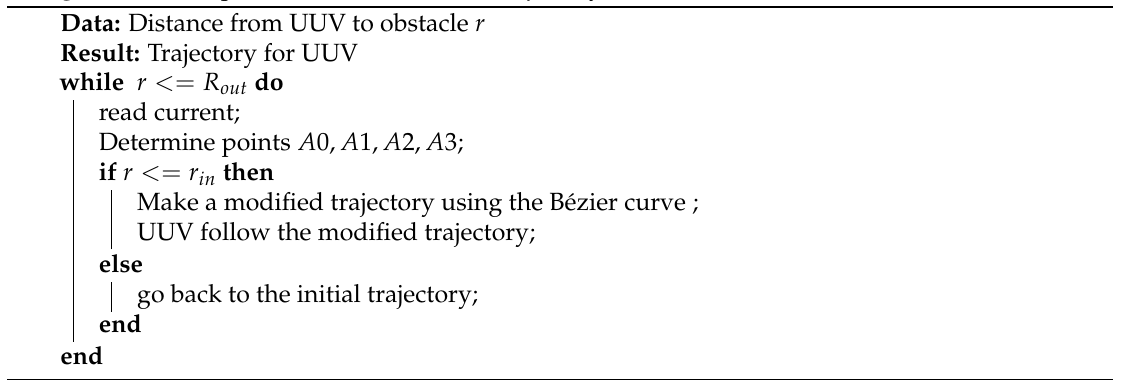
Algorithm 1: Propose to make a modified trajectory for obstacle avoidance. Data: Distance from UUV to obstacle